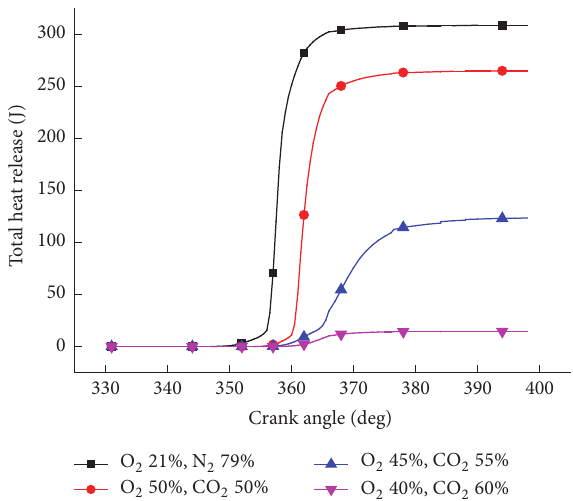
Figure 6: Curve of total heat release under different O 2 volume